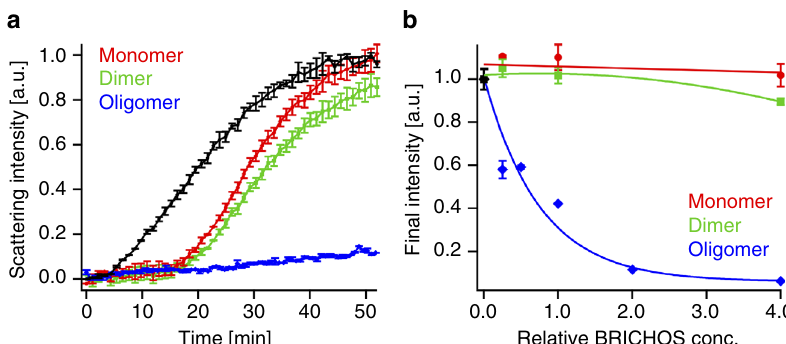
Fig. 6 Ability of different rh Bri2 BRICHOS species to suppress citrate synthase (CS) non- fi brillar aggregation. a Kinetics of aggregation of 600 nM citrate synthase (CS) at 45 °C alone (black), in the presence of 1.2 µ M rh Bri2 BRICHOS oligomer (blue), 2.4 µ M dimer (green) or 2.4 µ M monomer (red). b Effects of rh Bri2 BRICHOS oligomers (blue), dimers (green) and monomers (red) on CS aggregation at different molar ratios (referred to monomeric subunits) of BRICHOS:CS. The data are presented as means ± standard deviations of 3 – 4 replicates of experiments that have been repeated at least fi ve times with qualitatively similar results